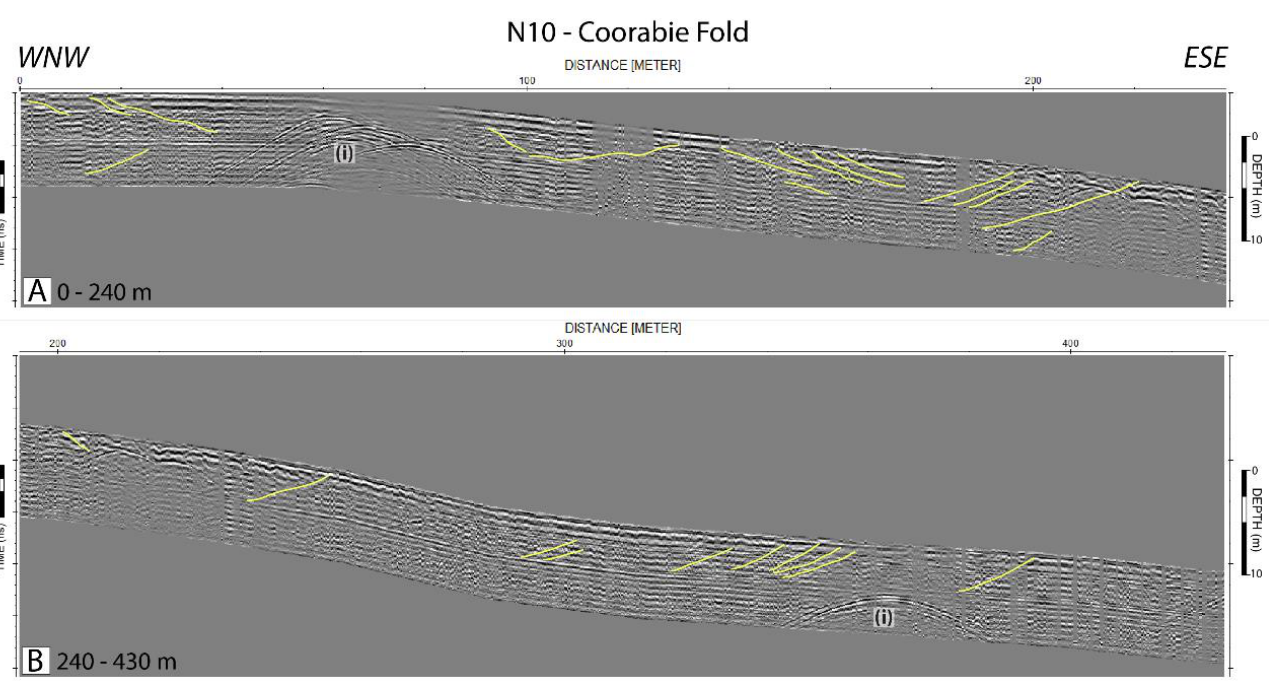
Figure 13. ( A , B ): GPR transect N10, interpreted reflectors shown in yellow; (i): wide hyperbolas indicating airwave reflections from trees.